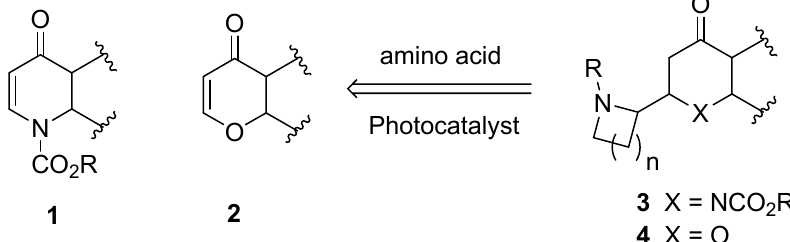
Figure 1. Decarboxylative additions to cyclic vinylogous amides and esters.